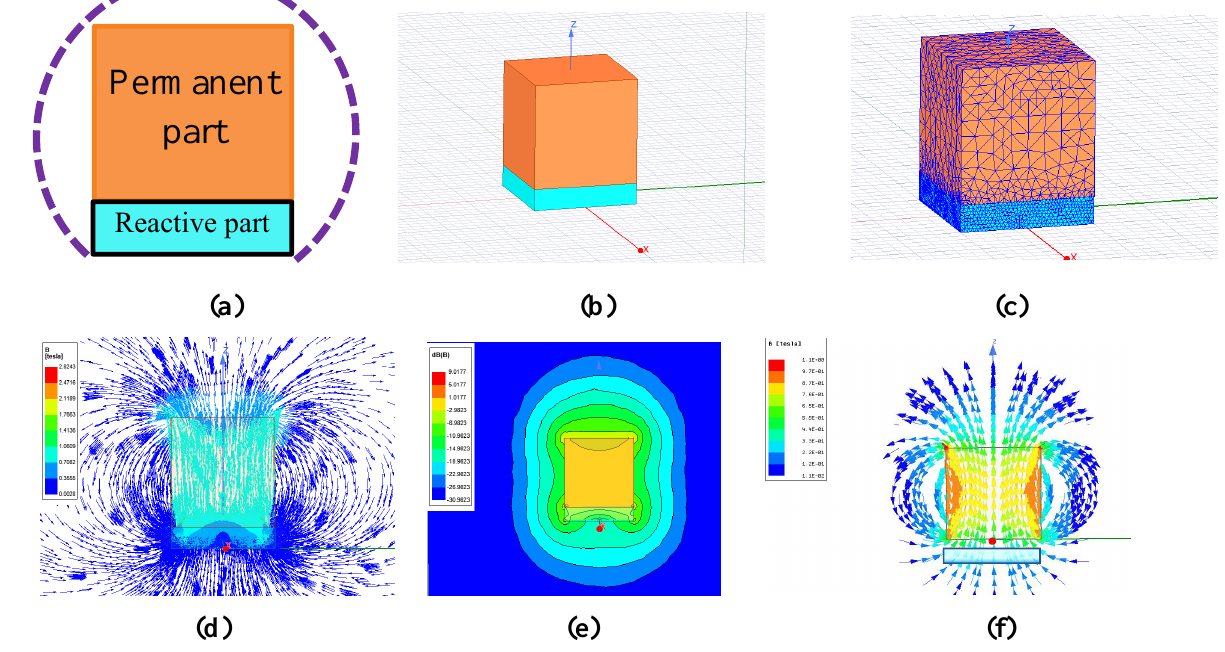
Figure 2. Functional Magnetic Materials (FMM): ( a ) general schematic diagram, ( b ) 3D view, ( c ) numerical model with a 1 mm size mesh, ( d ) magnetic flux density propagation, ( e ) magnetic flux density in iso values, and ( f ) magnetic